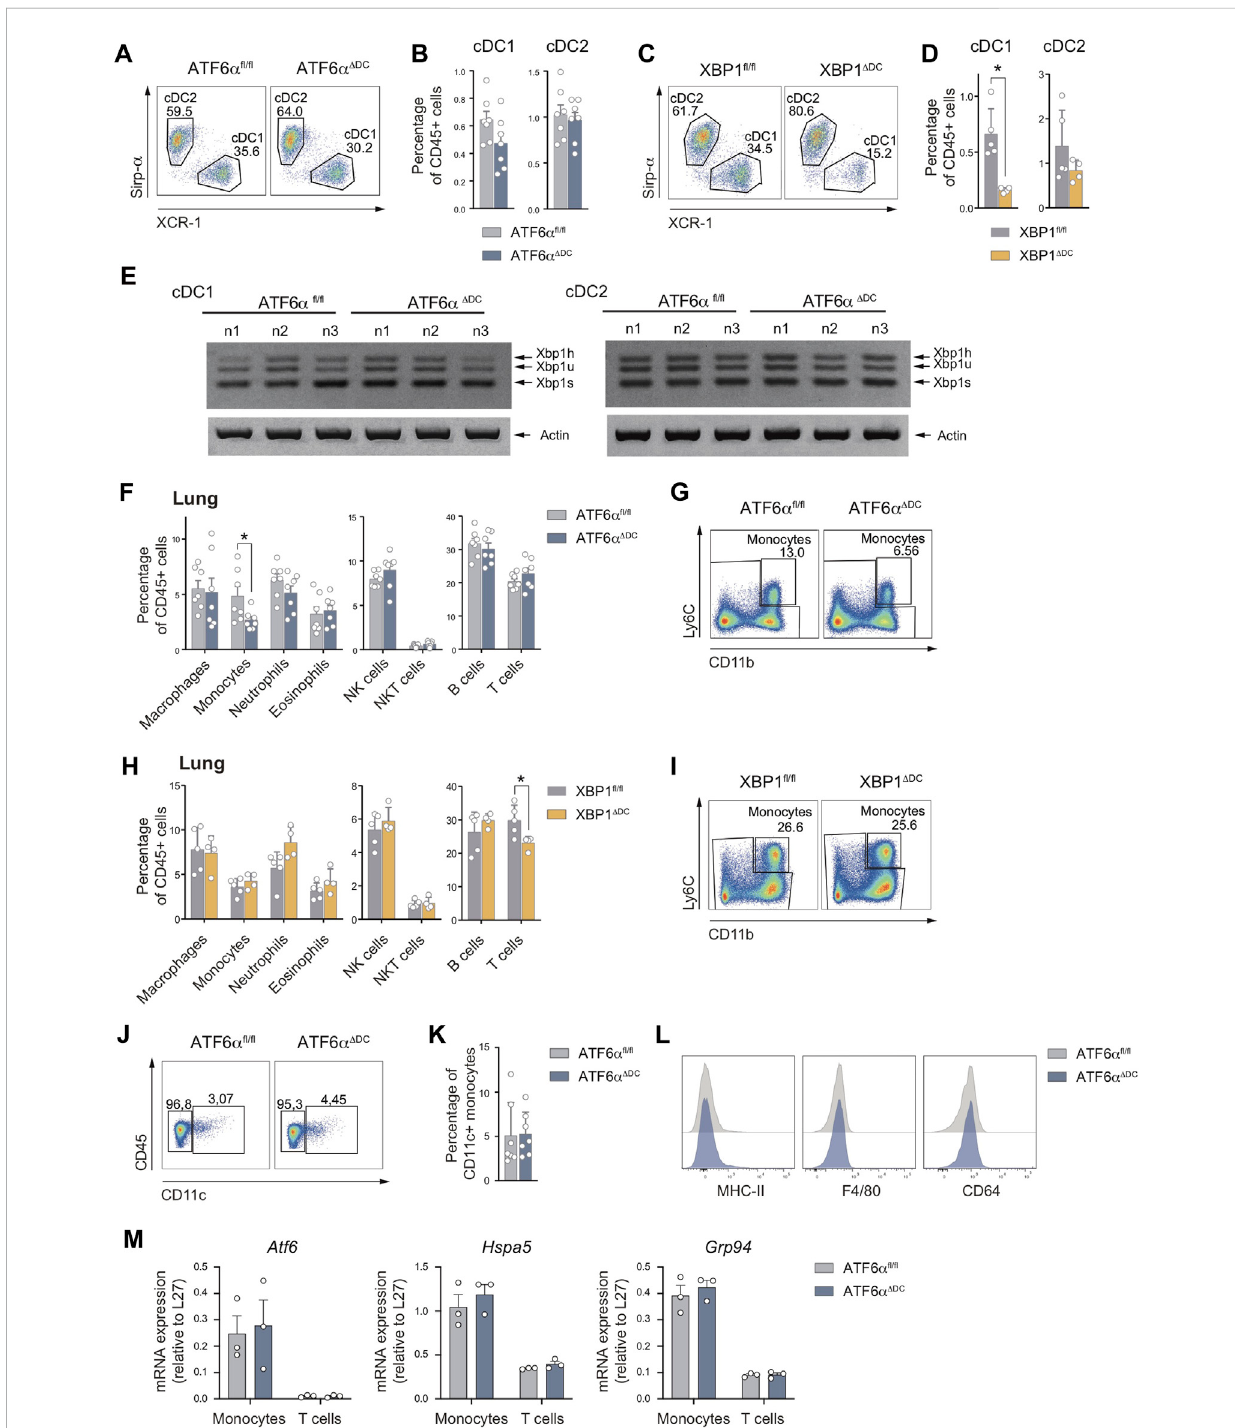
The loss of lung cDC1s observed upon XBP1 deletion is not recapitulated by de fi ciency of ATF6 α (A) Representative fl ow cytometry plots showing distribution of cDC1s and cDC2s in lung of ATF6 α fl / fl and ATF6 α Δ DC mice. (B) Percentage of cDC1s and DC2s relative to CD45 + cells from lung of ATF6 α fl / fl ( n = 7 mice) and ATF6 α Δ DC mice ( n = 7 mice). Bar graph depicts mean percentage of cells (±s.e.m.). Each symbol represents one sample obtained from 3independentexperiments. (C) Representative fl ow cytometryplots showing distribution ofcDC1s and cDC2s inlung of XBP1 fl / fl and XBP1 Δ DC mice. (D) Percentage of cDC1s and DC2s relative to CD45 + cells from lung of XBP1 fl / fl ( n = 5 mice) and XBP1 Δ DC mice ( n = 4 mice). Bar graph depicts mean percentage of cells (±s.e.m.). Each symbol represents one sample obtained from two independent experiment. (E) RT-PCR analysis of Xbp1 splicing in cDC1s and cDC2s sorted from spleen of ATF6 α fl / fl ( n = 3 mice) and ATF6 α Δ DC mice ( n = 3 mice). Data were obtained from two independent experiments. Xbp1h: Xbp1 hybrid, Xbp1u: Xbp1 unspliced, Xbp1s: Xbp1 spliced. Actin (bottom) serves as a loading control. (F) Percentage of immune cells relative to CD45 + cells from lung of ATF6 α fl / fl ( n = 7 mice) and ATF6 α Δ DC mice ( n = 7 mice). Bar graph depicts mean percentage of cells (±s.e.m.). Each symbol represents one sample obtained from 3 independent experiments. (G) Representative fl ow cytometry plots showing monocytes from lung of ATF6 α fl /